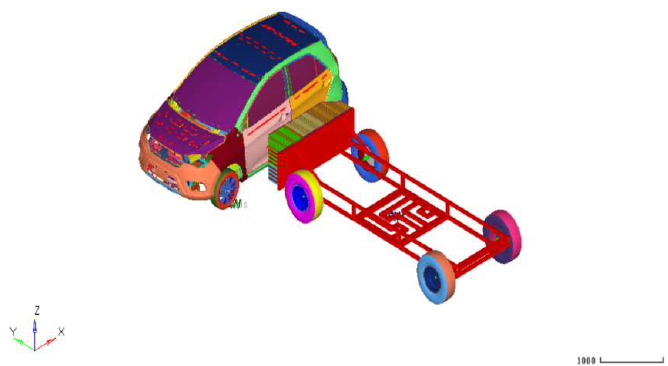
Figure 9. FEM of whole-vehicle-side crash.